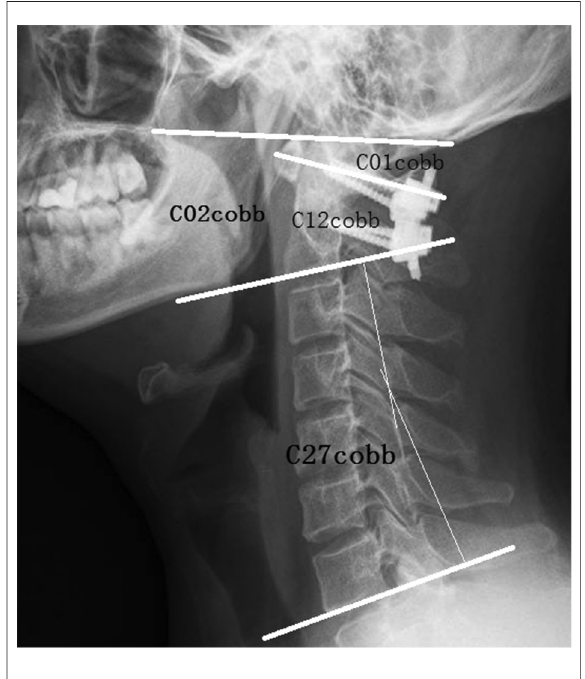
FIGURE 1 The measurement method of cervical spinal